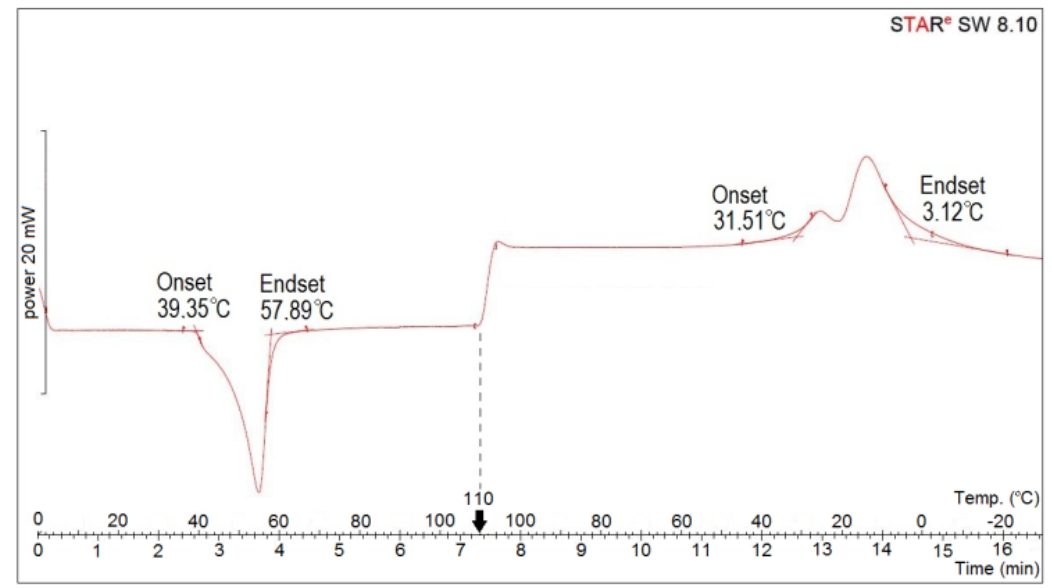
Figure 3. Differential scanning calorimetry (DSC) curve for SMA elements after thermomechanical cycling.